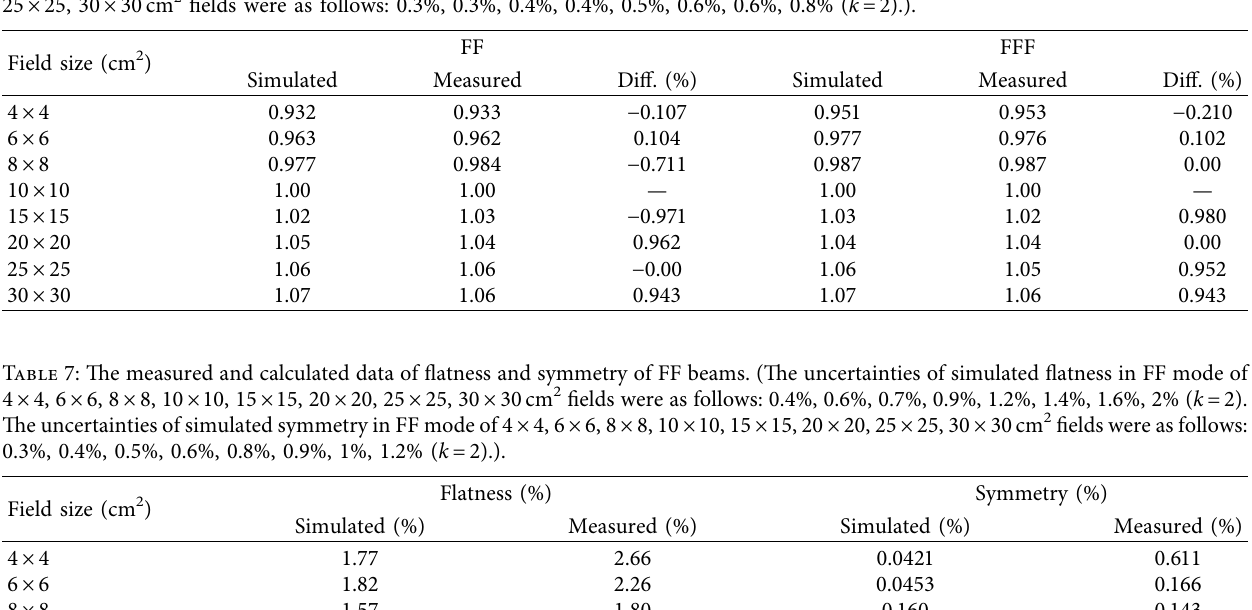
d for FF and FFF beams. (The uncertainties of max